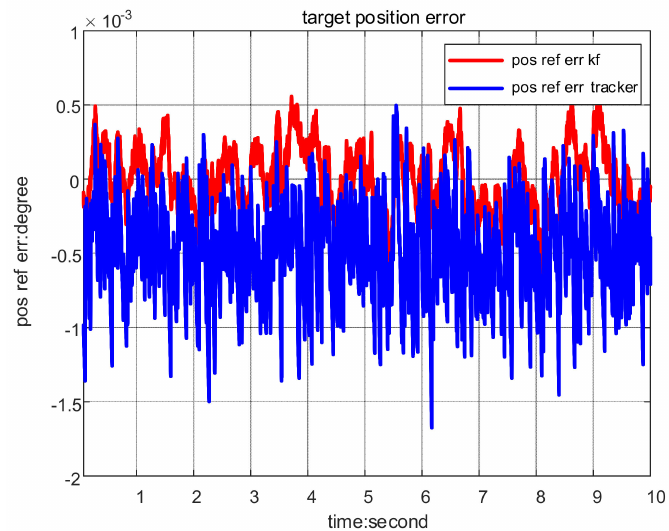
Figure 7. Deviation curve of the target position.